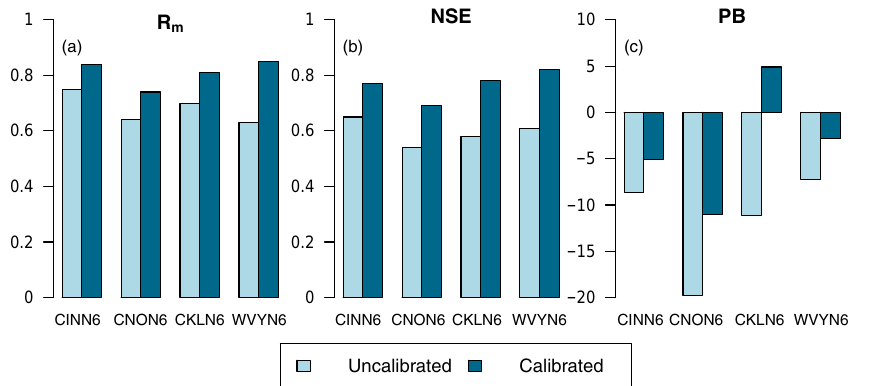
Figure 2. Performance statistics for the uncalibrated and calibrated simulation runs for the entire period of analysis (years 2004–2012): (a) R m , (b) NSE, and (c)